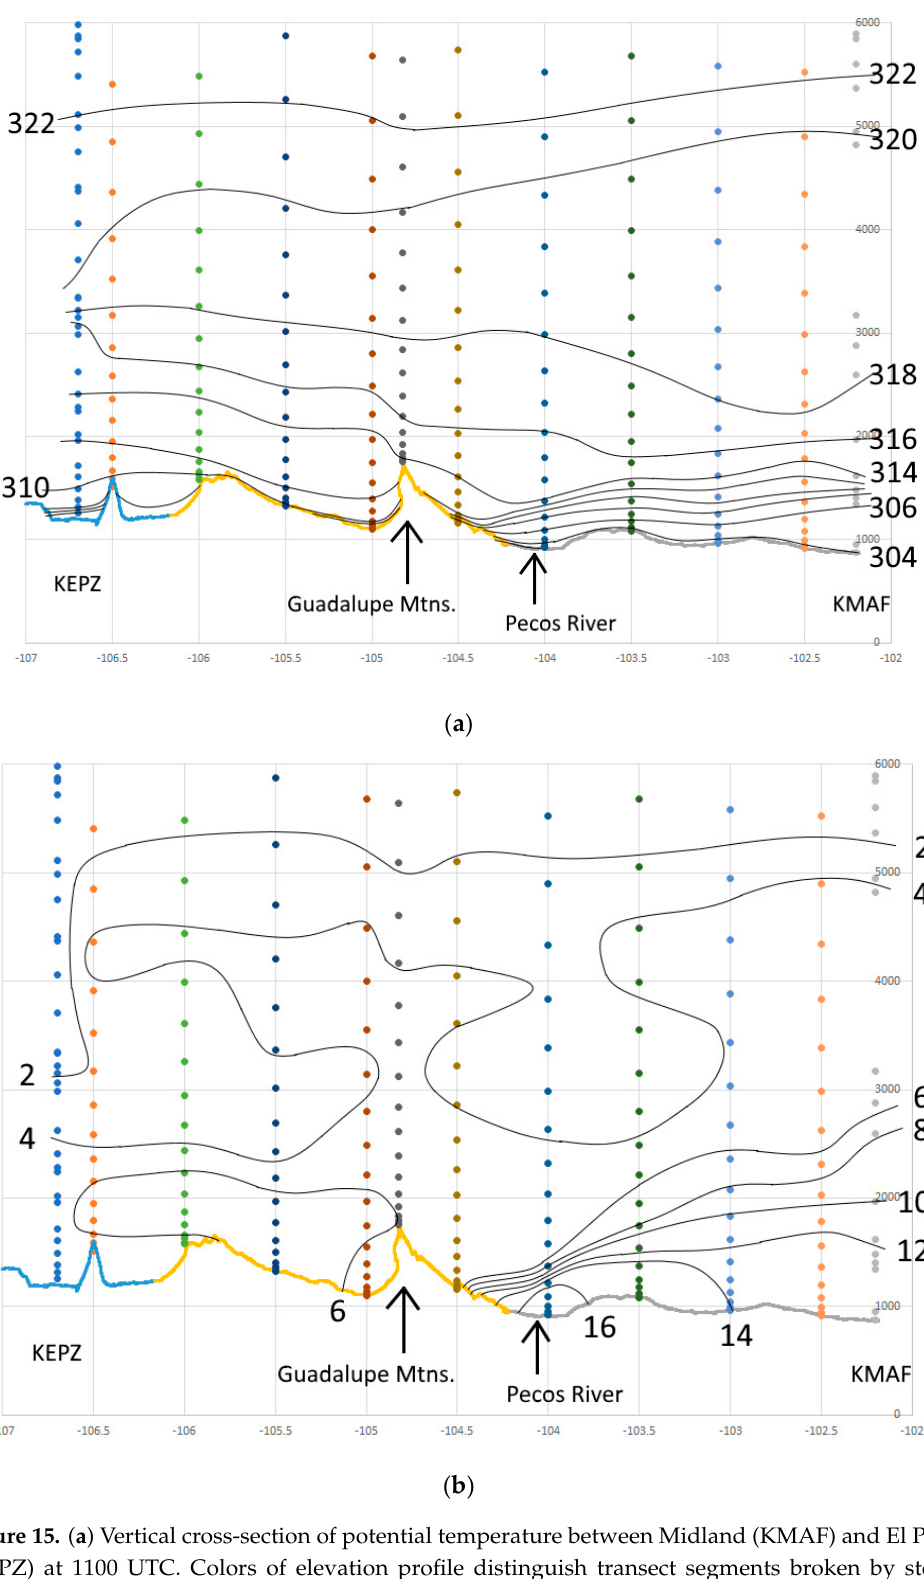
Figure 15. ( a ) Vertical cross-section of potential temperature between Midland (KMAF) and El Paso (KEPZ) at 1100 UTC. Colors of elevation profile distinguish transect segments broken by stops. ( b ) Vertical cross-section of mixing ratio.